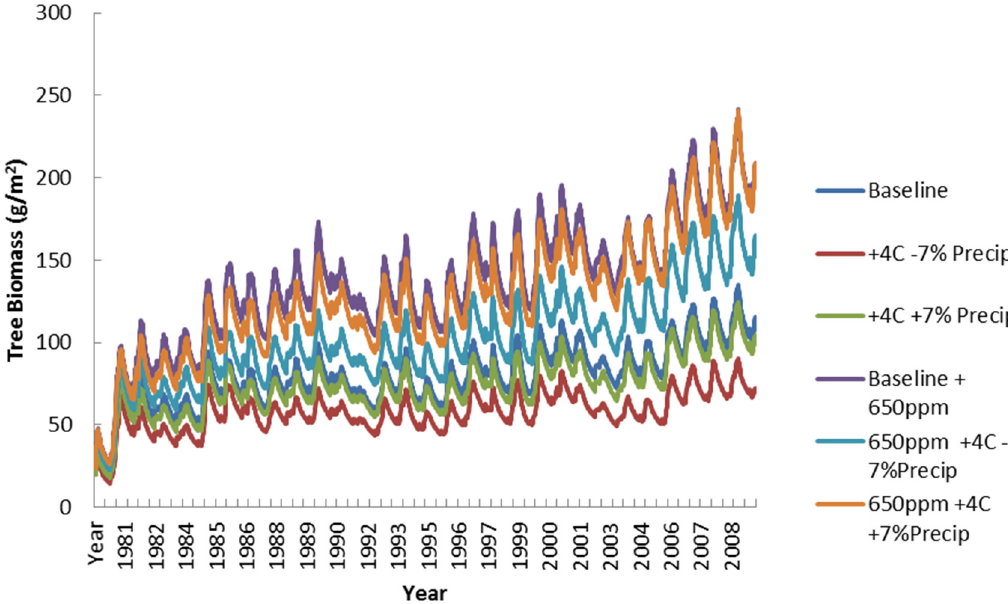
Figure 17. Simulated tree biomass (g/m 2 ) for all climate scenarios.